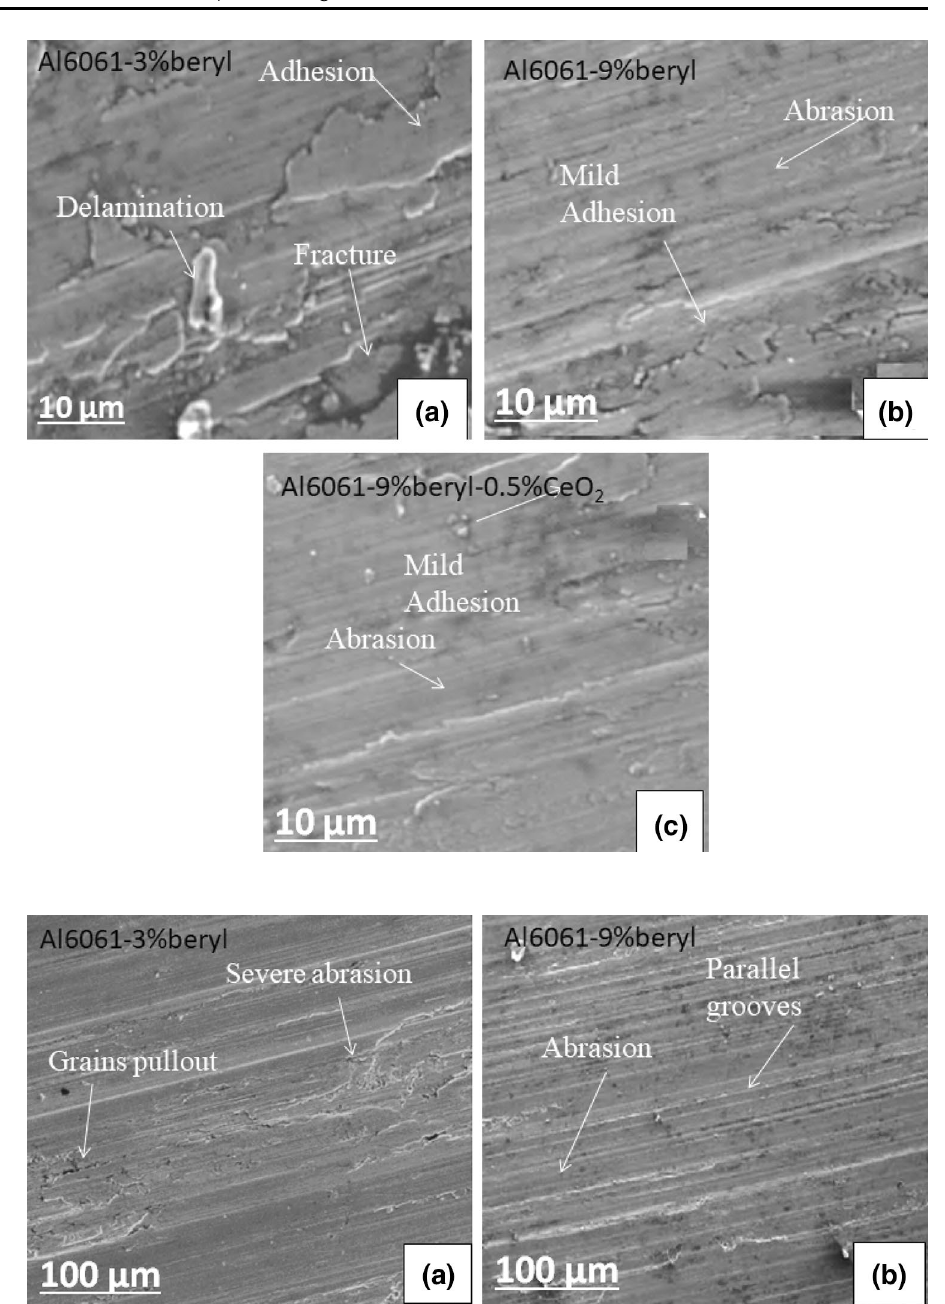
Fig. 9 Worn surfaces of ( a ) “Al6061–3% Beryl,” ( b ) “Al6061– 9% Beryl” and ( c ) “Al6061–9% Beryl–0.5% CeO